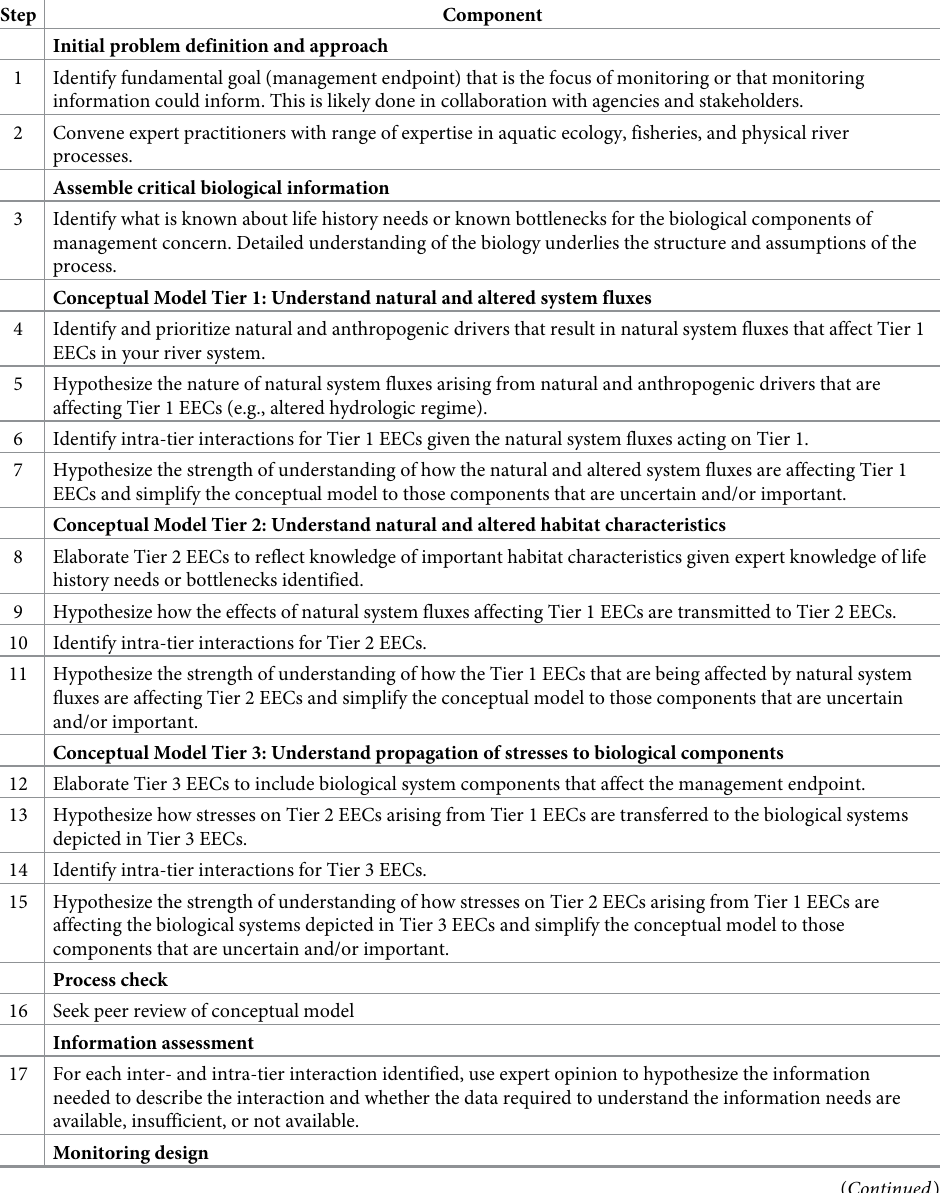
Table 4. The recommended steps to conduct the conceptual modelling